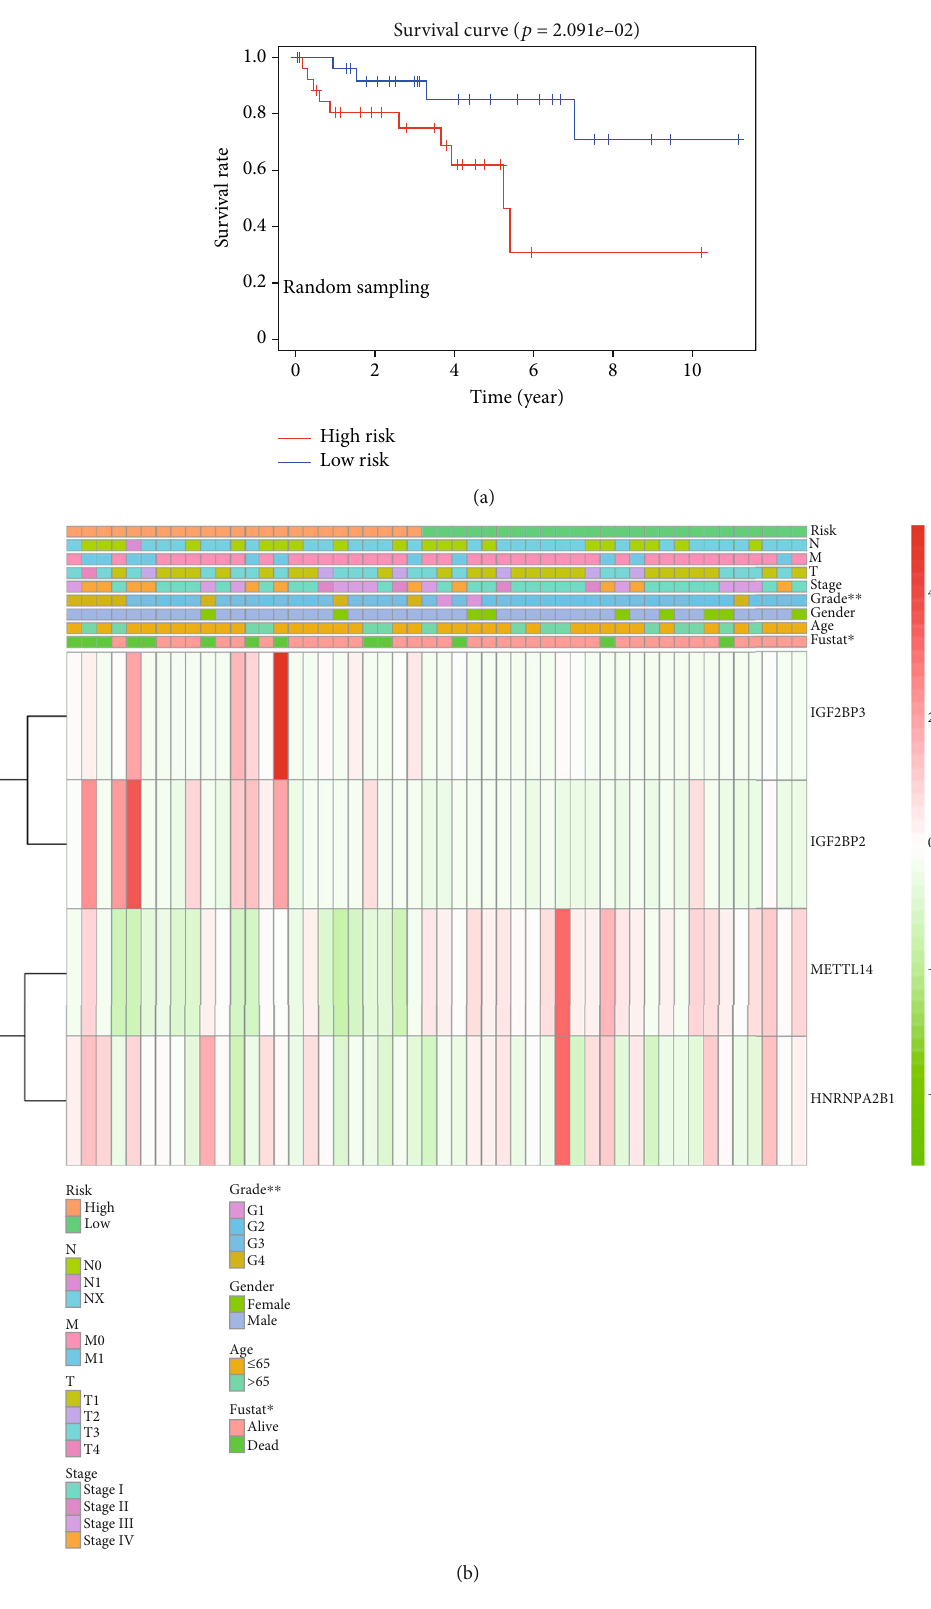
Figure 7: Random sampling of data in TCGA to validate the accuracy of the signature. (a) Kaplan-Meier overall survival (OS) rate curve of high-risk (red) and low-risk (blue) patients with ccRCC. Data was obtained by random sampling from TCGA. (b) Heat map of clinicopathological features and expression levels of IGF2BP3, IGF2BP2, HNRNPA2B1, and METTL14 genes in the randomly sampled